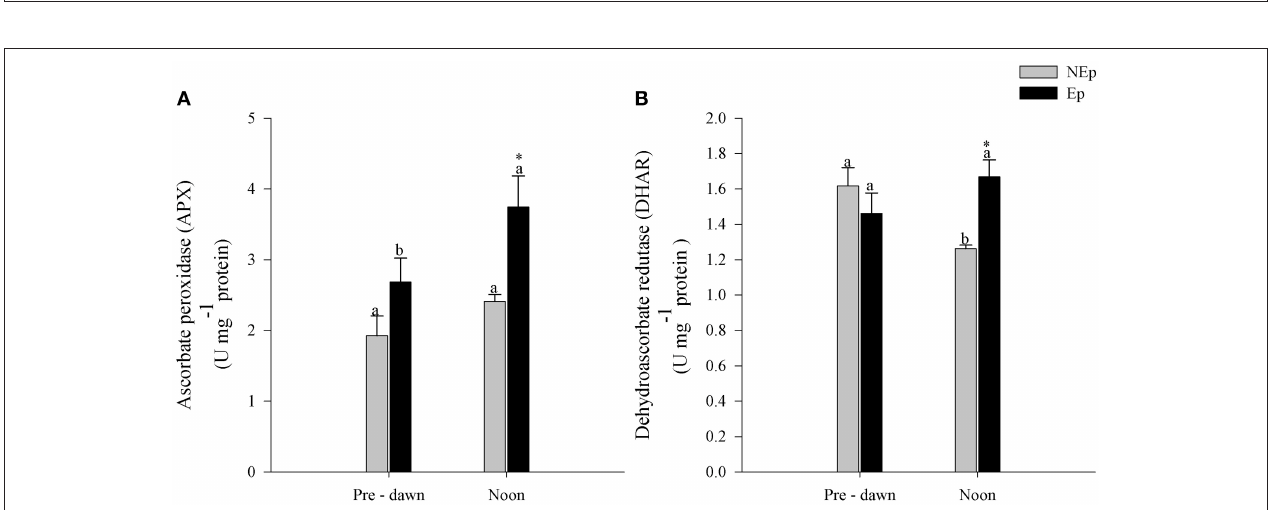
FIGURE 3 | Leaf soluble sugars (A) and starch (B) in Posidonia oceanica leaves with (Ep) and without (NEp) epiphytes, at pre-dawn and noon. Different letters indicate significant differences between pre-dawn and noon; * indicates significant differences between Ep and NEp leaves ( n = 5 , p < 0.05 ).